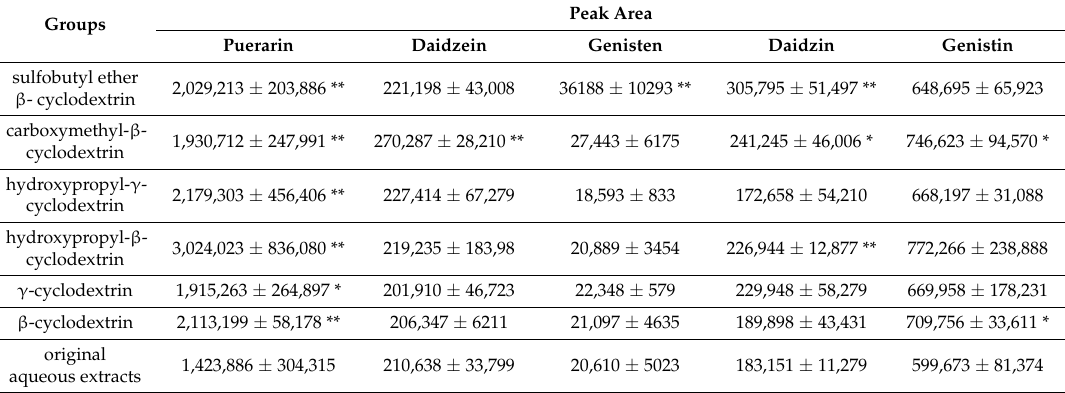
Table 1. Associated-extraction efficiency of six CDs for flavonoids (peak area, n = 6).